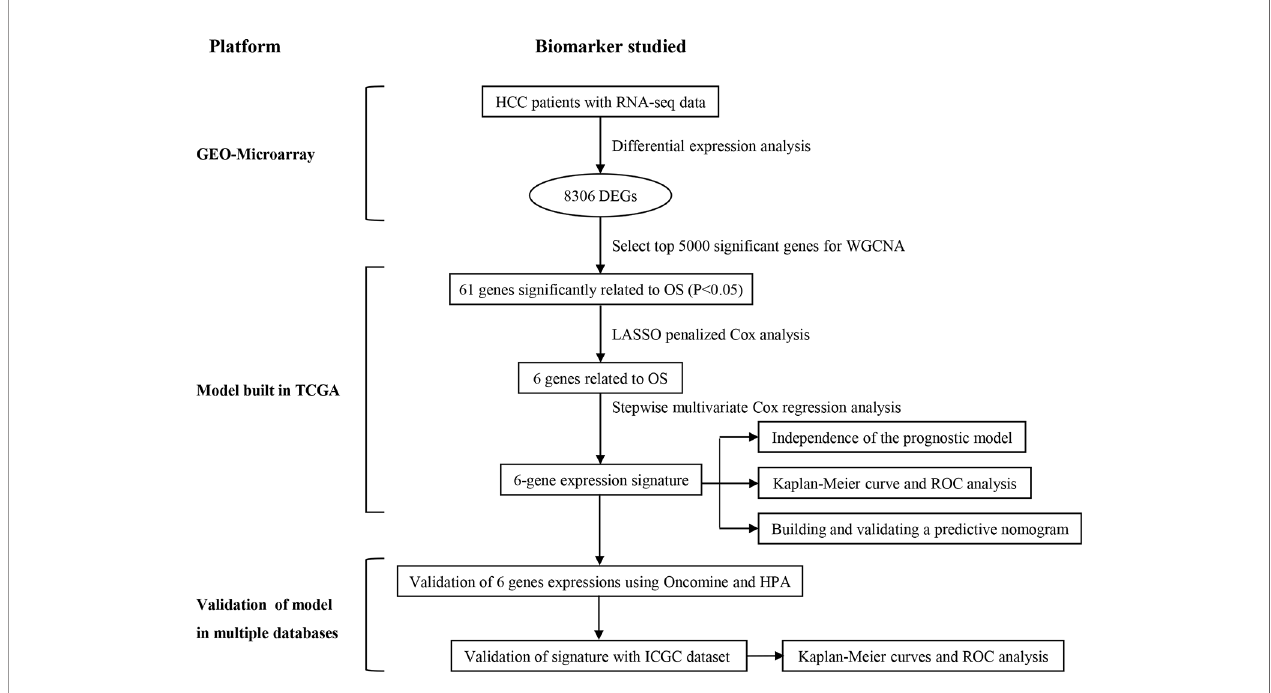
FIGURE 1 | Overall fl owchart of this